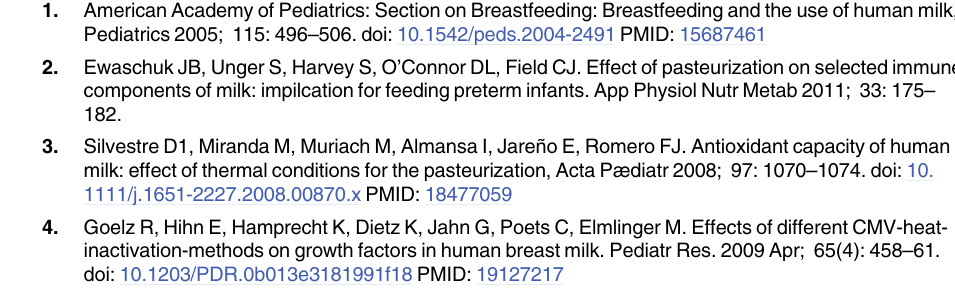
S1 Fig. Percentage and mean intake of EBM over time for each week